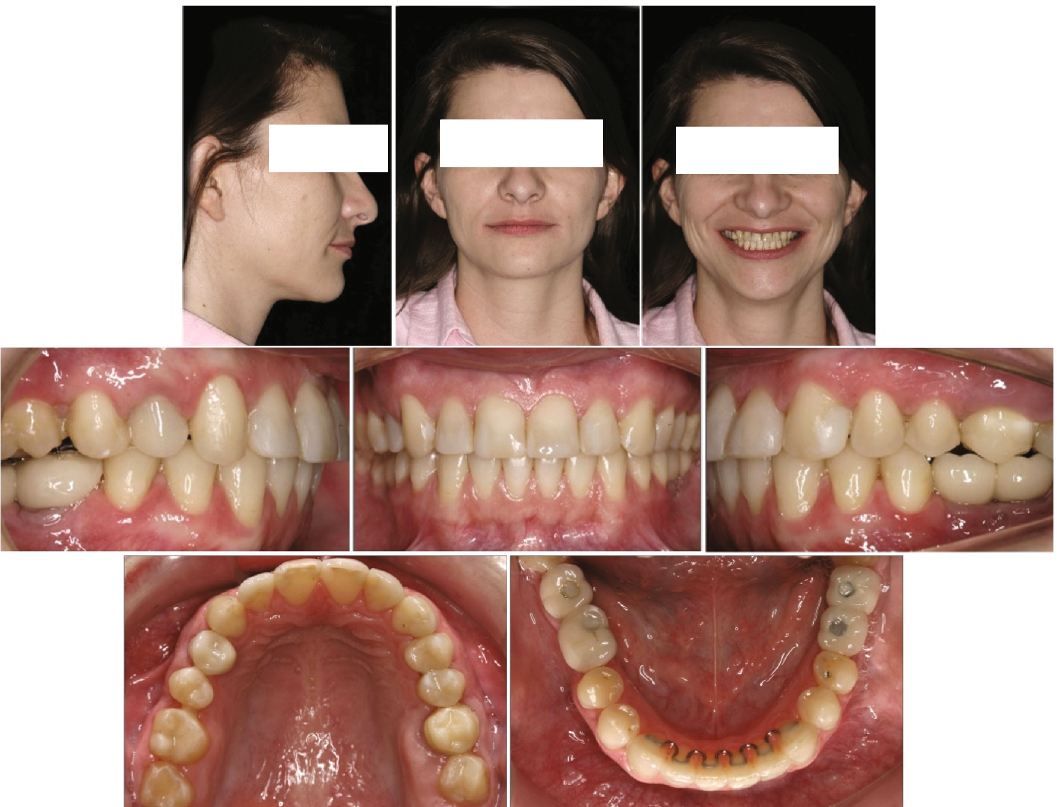
Figure 7: Posttreatment facial and intraoral photograph.